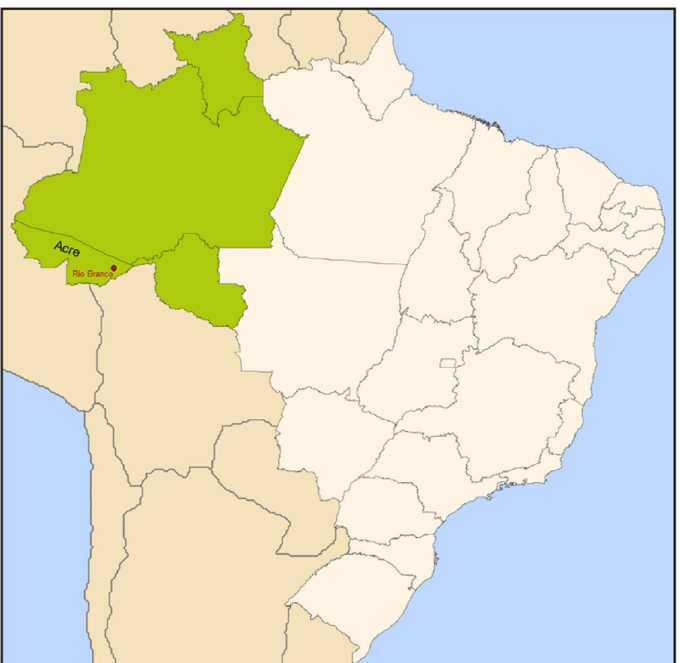
Figure 1. Map showing the location of Rio Branco, capital of the Acre State, in the western Brazilian Amazon (in green).